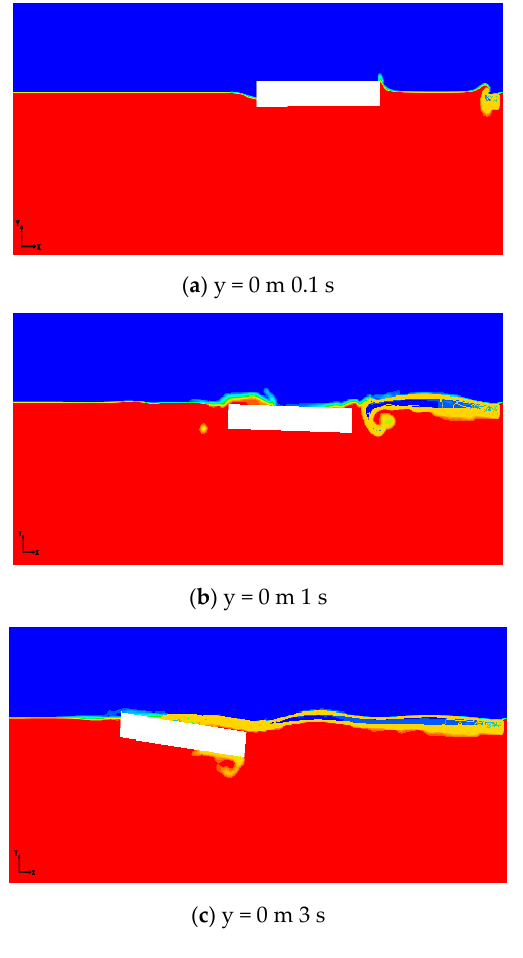
Figure 10. Oil-spreading characteristics of the ice particle with six-degrees-of-freedom (6DOF) movement at y = 0 m plane section.